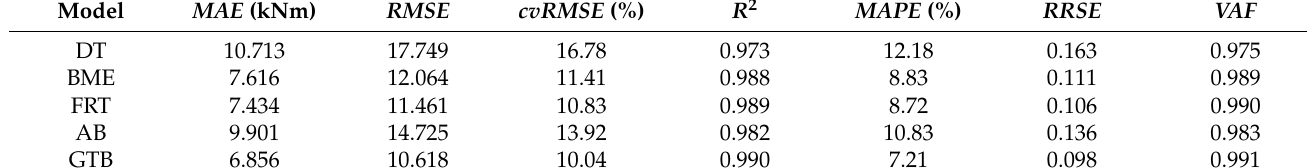
Table 6. Performance metrics for the testing results.